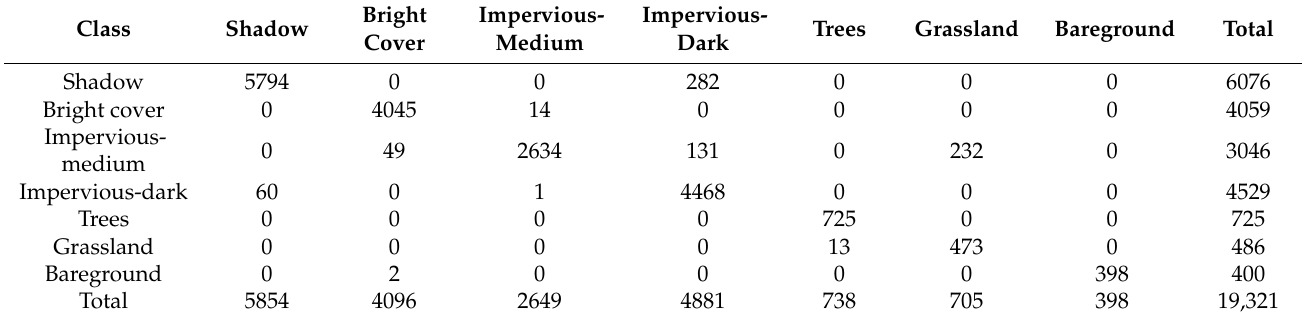
Table 3. The confusion matrix shows the number of correctly and incorrectly classified pixels of the QuickBird image. Class Shadow